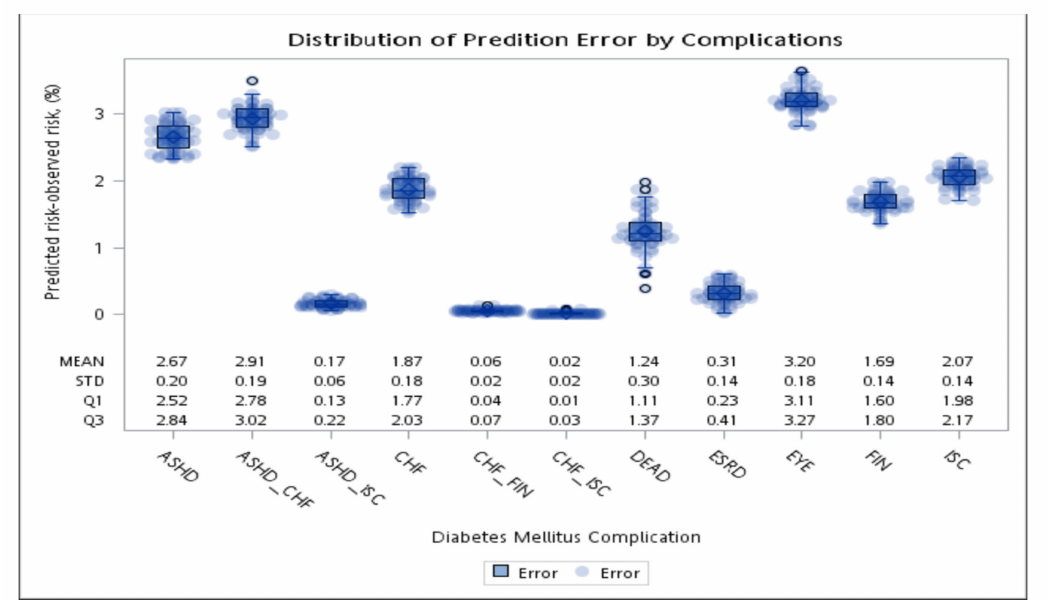
Figure 8. The average absolute error of the first event (complication or death) after diabetes diagnosis between the simulation and observations in 10